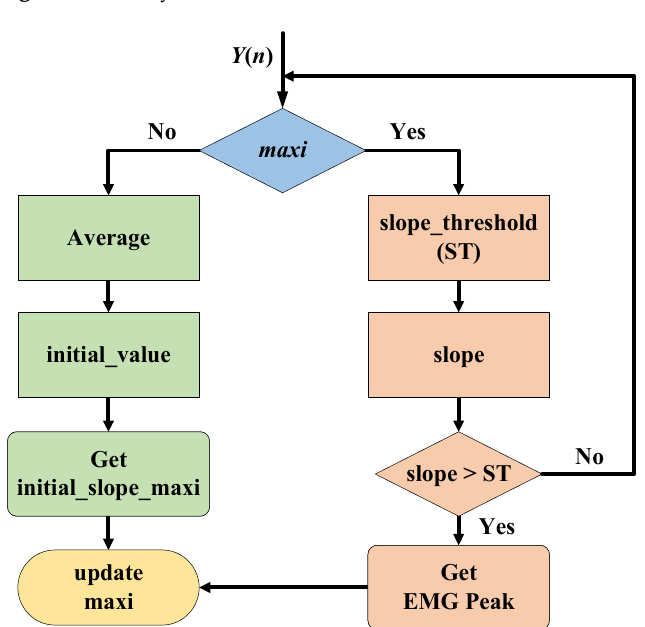
Figure 4. ACD system flowchart. Figure 5 is the average slope maximum So and Chan (ASM S & C) system flowchart.